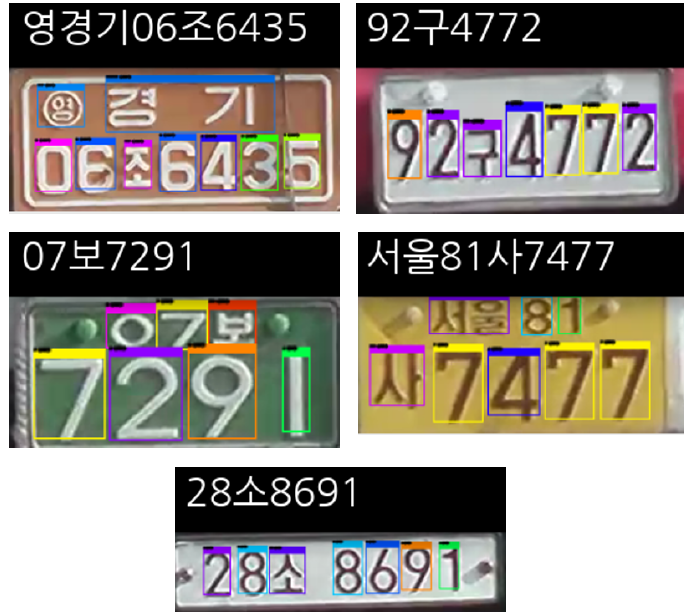
Figure 14. Output examples of the LPC detector in phase 2 using our dataset which reads as ‘Yeong Gyeonggi 06 Jo 6435’, ‘92 Gu 4772’, ‘07 Bo 7291’, ‘Seoul 81 Sa 7477’, and ‘28 So 8691’,